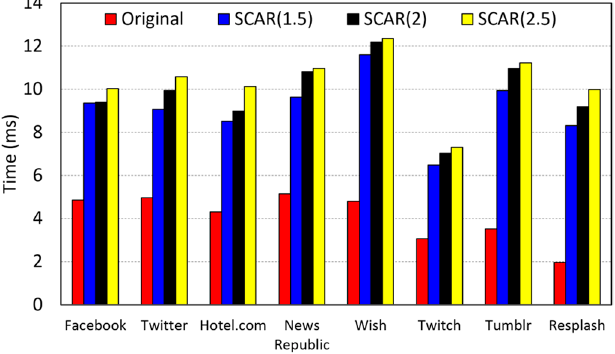
Figure 13. Execution time of the method draw() of class CanvasContext in a frame rendering operation.